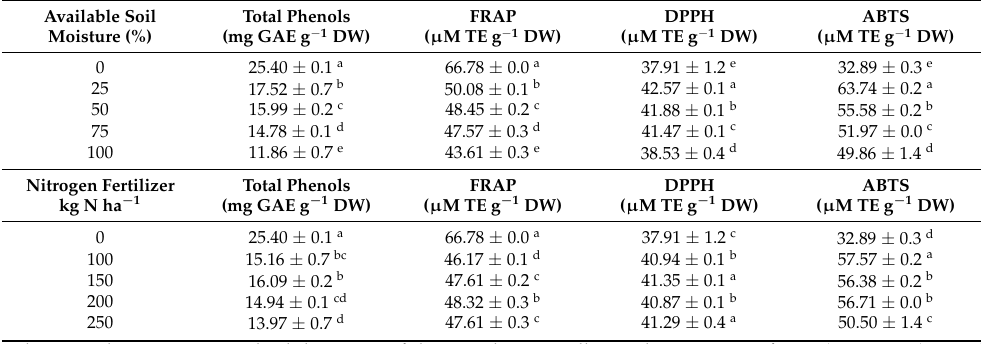
Table 4. Total phenol content and antioxidant activity (FRAP, DPPH and ABTS) in onion bulbs ( Allium cepa L.) grown at different levels of available soil moisture and nitrogen fertilization. Available Soil Moisture